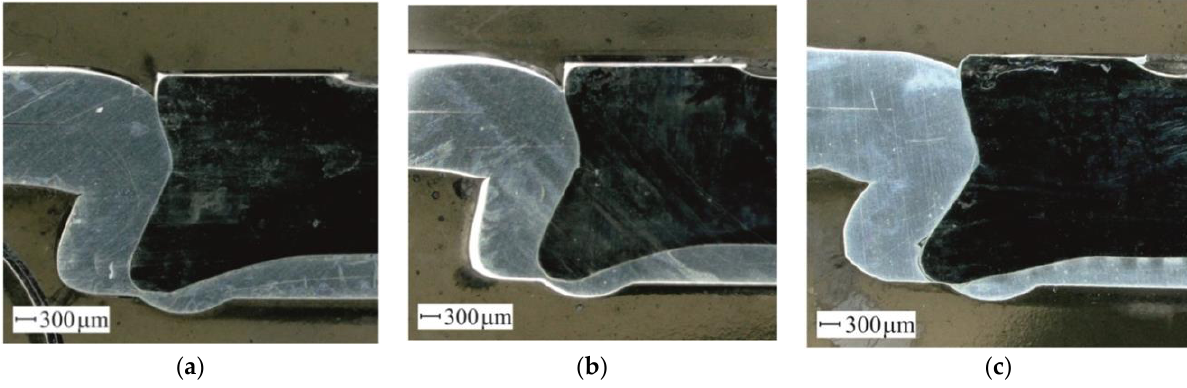
Figure 18. The joint cross-sections: ( a ) arrangements no.1 (AW 5754-H11 with AW 5754-H11), ( b ) arrangements no.4 (AW 5754-H22 with AW 5754-H22), ( c ) arrangements no.7 (AW 5754-H24 with AW 5754-H24).